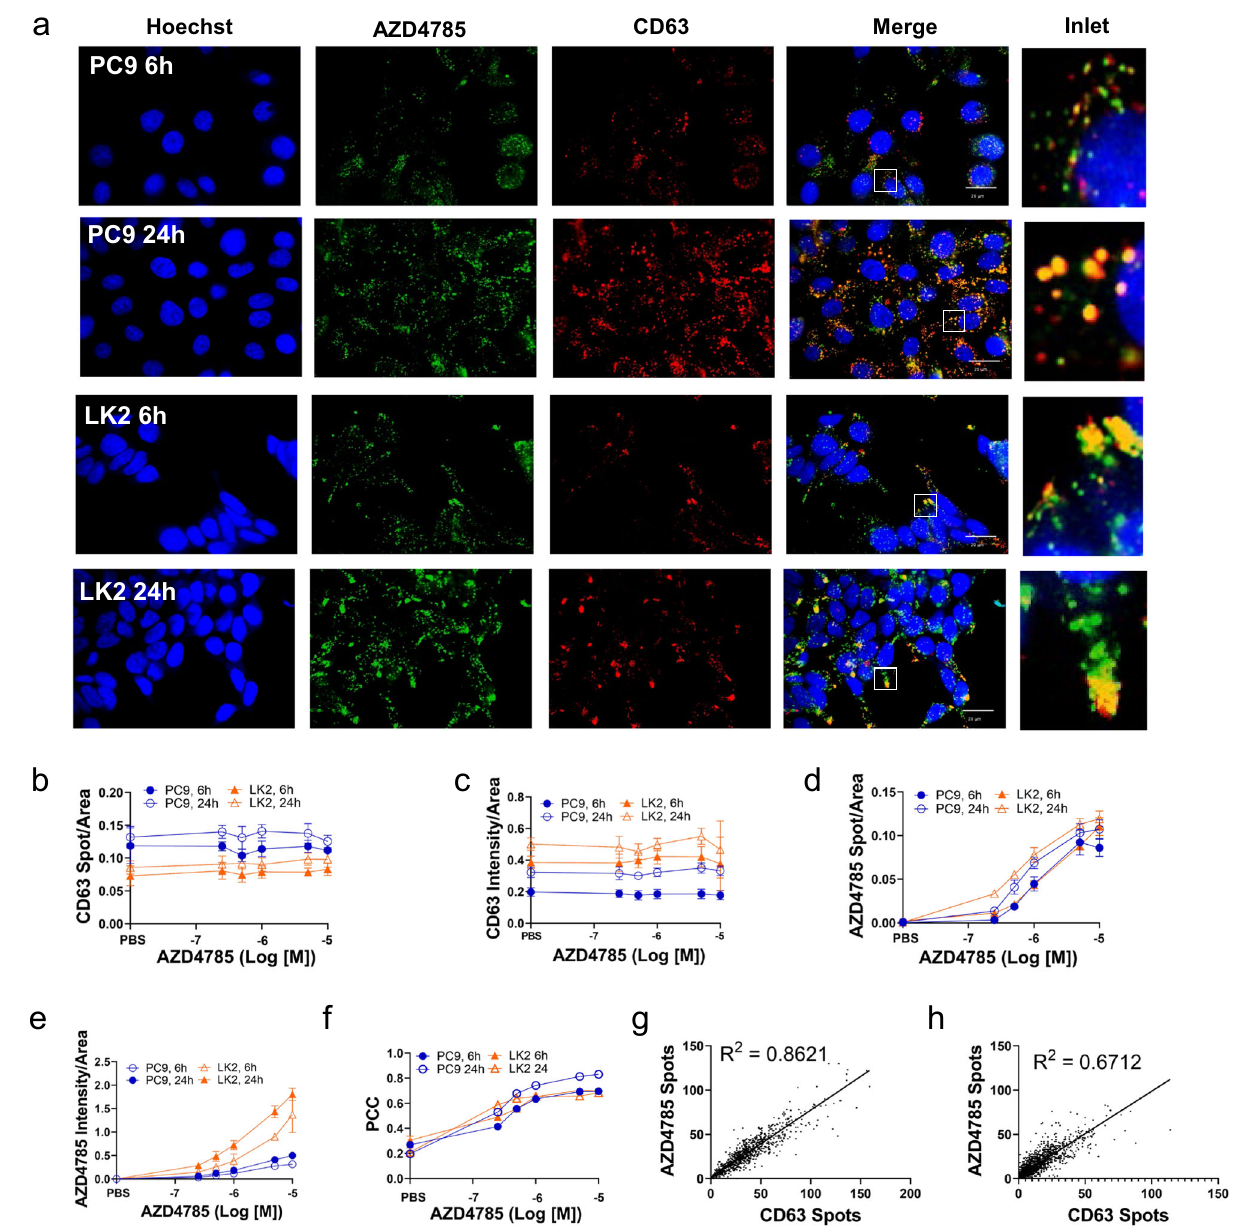
Fig. 1 AZD4785 is delivered to the CD63-positive LE compartment in PC9 and LK2 cells. a PC9 and LK2 cells were incubated with AZD4785 for 6 or 24 h, then fi xed and stained. LE and AZD4785 were stained with anti-CD63 and anti-PS-ASO antibodies, respectively and visualised using secondary fl uorescently labelled antibodies. Nuclei were stained with Hoechst 33342. Cell images were acquired using Opera microscope (×60 objective, NA1.4). b – e Intracellular content of AZD4785 and CD63 were quanti fi ed by using Columbus software by counting number of stained spots in the cell cytosol (Spot/Area) or integrated intensity (Intensity/Area). Number of spots and integrated intensity were normalised to the cellular cytosol area. Average of means, error bars, standard deviation. Minimum 300 cells for each condition were counted in each experiment ( N = 3 – 6). f AZD4785 and CD63 colocalisation were calculated by Pearson ’ s correlation coef fi cient (PCC). N = 3, error bars, standard deviation (SD). g Correlation between intracellular AZD4785 and CD63 spots in single PC9 cells. 24 h treatment with AZD4785. N = 3, n = 948 cells. Linear regression analysis. h Correlation between intracellular ASO and CD63 spots in single LK2 cells. 24 h treatment with AZD4785. N = 3, n = 1759 cells. Linear regression